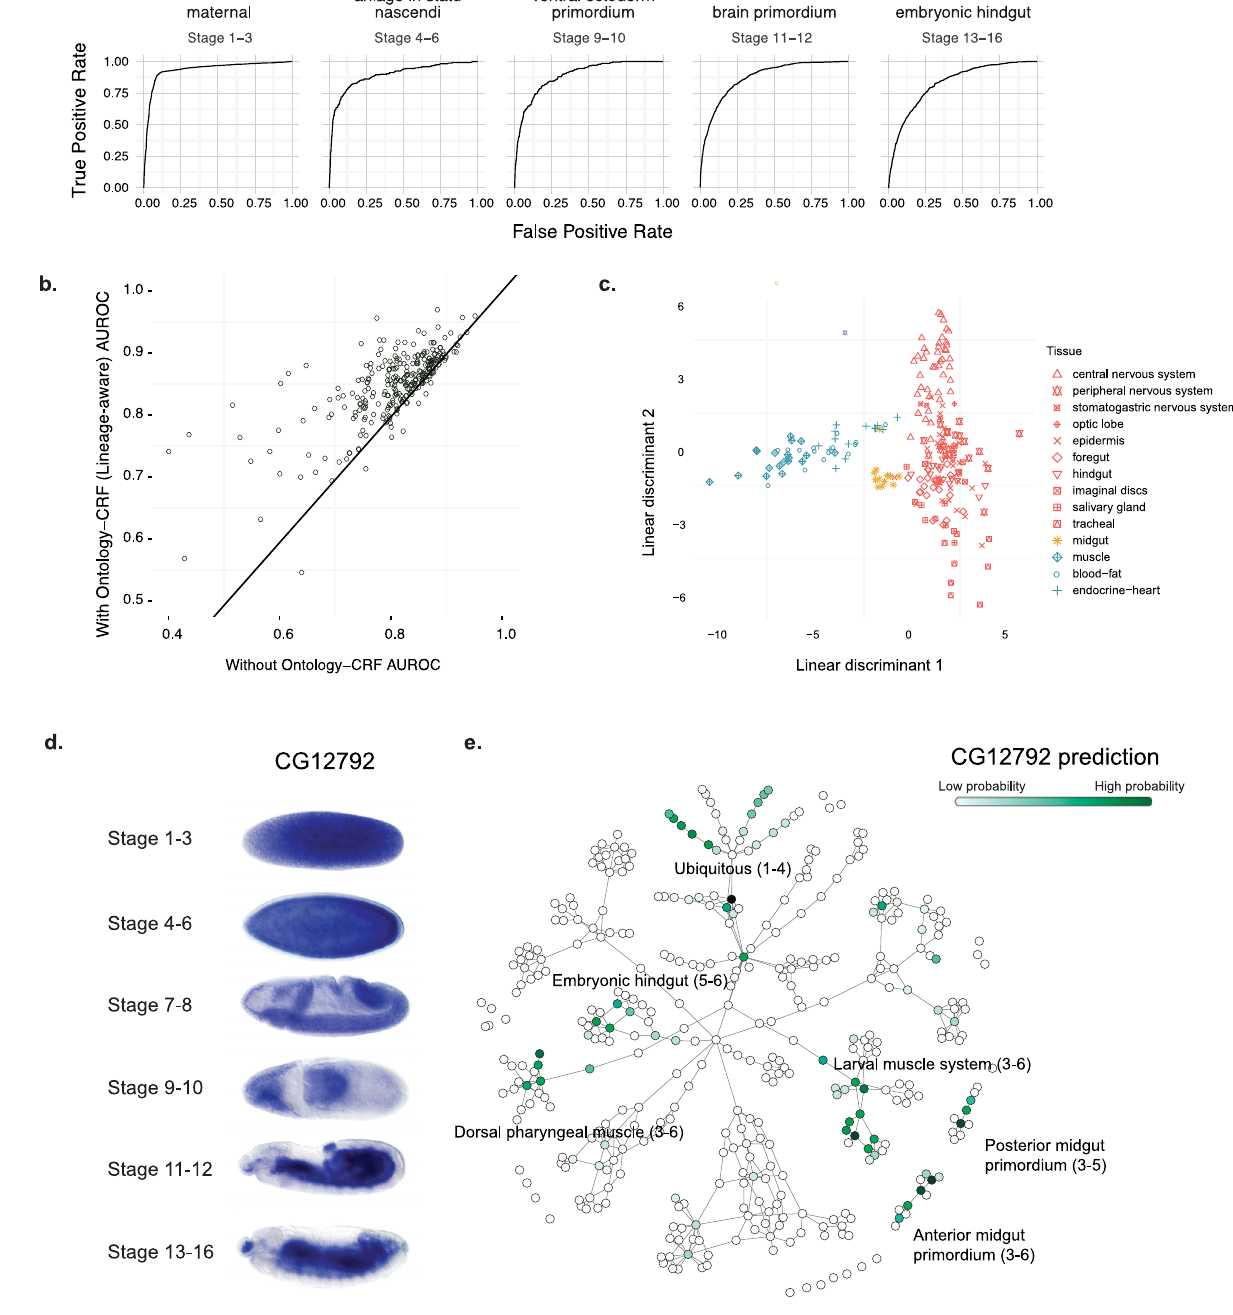
Fig 2. Tissue-developmental stage specificity of gene expression predictions. a. Gene expression prediction performances for selected tissue-stage categories measured by receiver-operating characteristics (ROC) curves. b. Integrating prediction across tissue-stages utilizing tissue developmental ontology information by ontology-CRF method improved prediction performances. The left panel compares area under ROC curves (AUROCs) for each tissue-stage category with and without using ontology-CRF integration. c. Global structure of predicted tissue-stage transcriptomes by embryonic layer of origin. The two dimensional projections of high-dimensional gene expression probability predictions were obtained with linear discriminant analysis (LDA) to best separate the tissue groups. Each point corresponds to a tissue-stage, the shape represent the tissue group and the color represent the embryonic layer of origin: light blue for mesoderm, yellow for endoderm and red for ectoderm. d-e. Example tissue-stage specificity predictions for CG12792. The observed expression patterns based on in situ hybridization were shown in d. The tissue-developmental categories and relationships were shown as a tree-like network (e), with nodes indicating tissue-stage categories and edges indicating “development from” and “part of” relationships. The color of each node represents the predicted probability of that category for the gene. Darker green color indicates higher predicted probability. Major tissue annotations and corresponding stages were labeled by